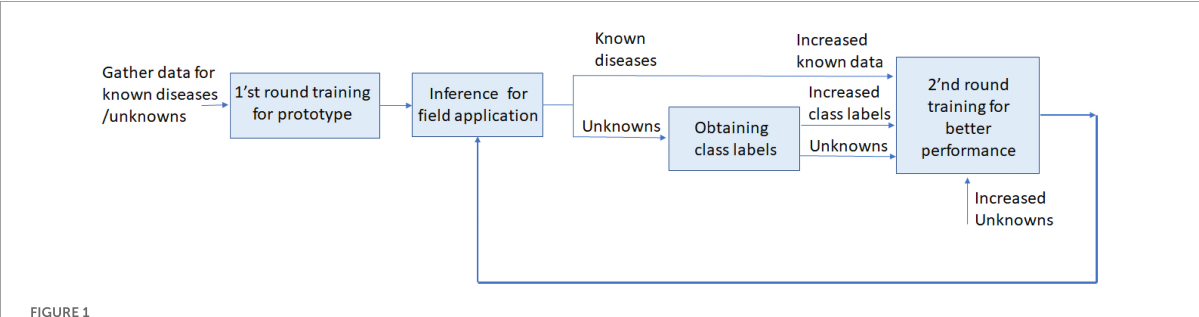
FIGURE1 Unknown detection and continual learning for plant disease